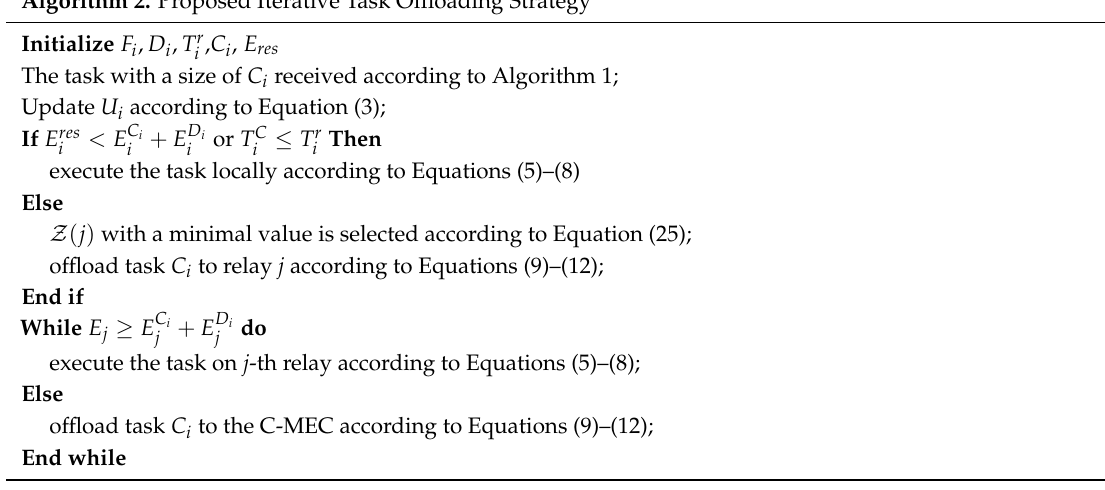
Algorithm 2. Proposed Iterative Task Offloading